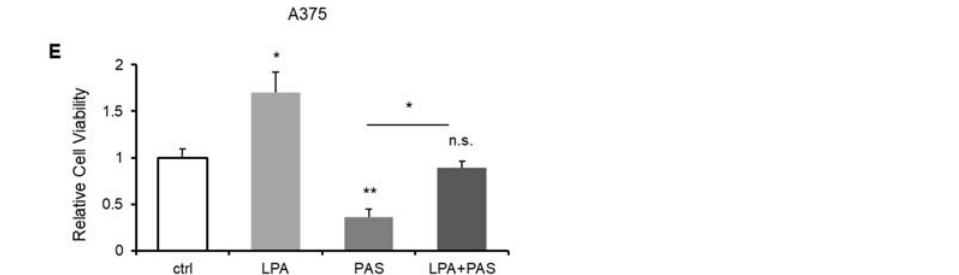
Figure 4. PAS regulated tumor growth in vivo through the glycerophospholipid metabolic pathway. Nude mice bearing A375 xenografts were treated with saline and PAS. ( A ) Volcano plot of the differential metabolite screening. ( B ) Cluster analysis of all differential metabolites. ( C ) Radar chart analysis of PAS vs. saline groups. ( D ) Metabolic pathway related to differential metabolites. (E) Cell proliferation was assessed using a cell counting kit (CCK) assay after the cells were treated with LPA (1 μ M) and PAS for 24 h. Data represent the mean ± SD; n = 3; * p < 0.05; ** p < 0.01.